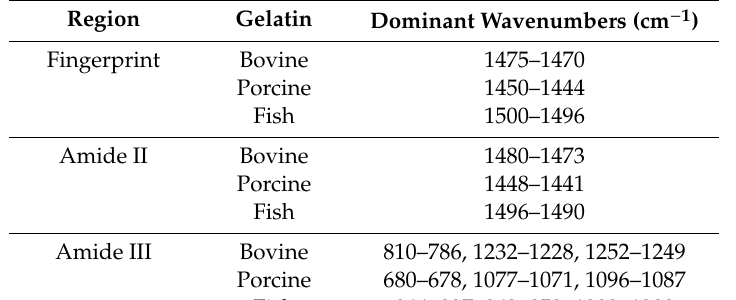
Table 2. Summary of dominant wavenumbers.